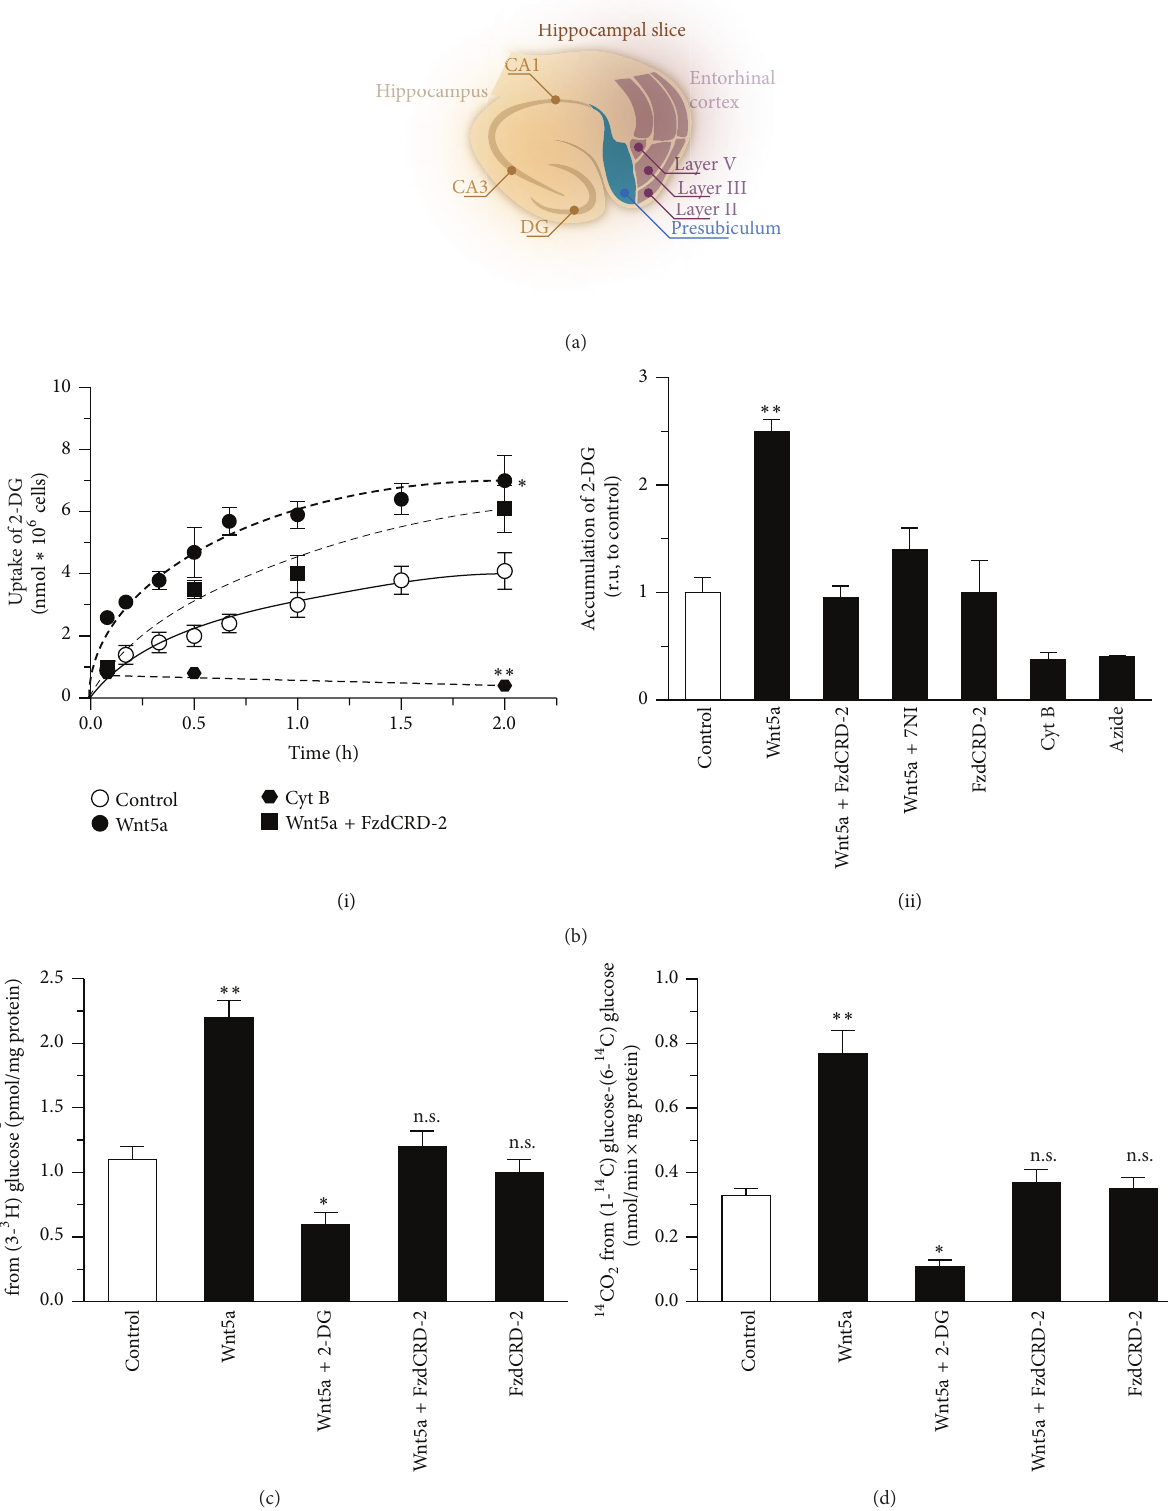
Figure 4: Wnt pathway activation stimulates the glucose metabolism in hippocampal slices. (a) Schematic representation of 350 𝜇 m hippocampal slice. (b) In slices, Wnt5a treatment induced an increase in the intracellular accumulation of 2-DG in a time-dependent manner (i); this effect was blocked by the coincubation with FzdCRD-2 (ii). (c) Slices incubated with Wnt5a showed an increase in the glycolytic rate; this effect was blocked by 2-DG and FzCRD-2. (d) In slices we observed an increase in the PPP activity. Data represent the mean ± SEM of 𝑛 = 5 , each performed in triplicate. ∗ 𝑝 < 0.01 ; ∗∗ 𝑝 < 0.005 , Bonferroni